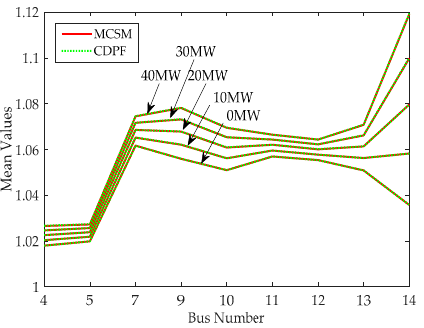
Figure 7. The means of the voltage magnitude at PQ buses with the rated power of the FCG at